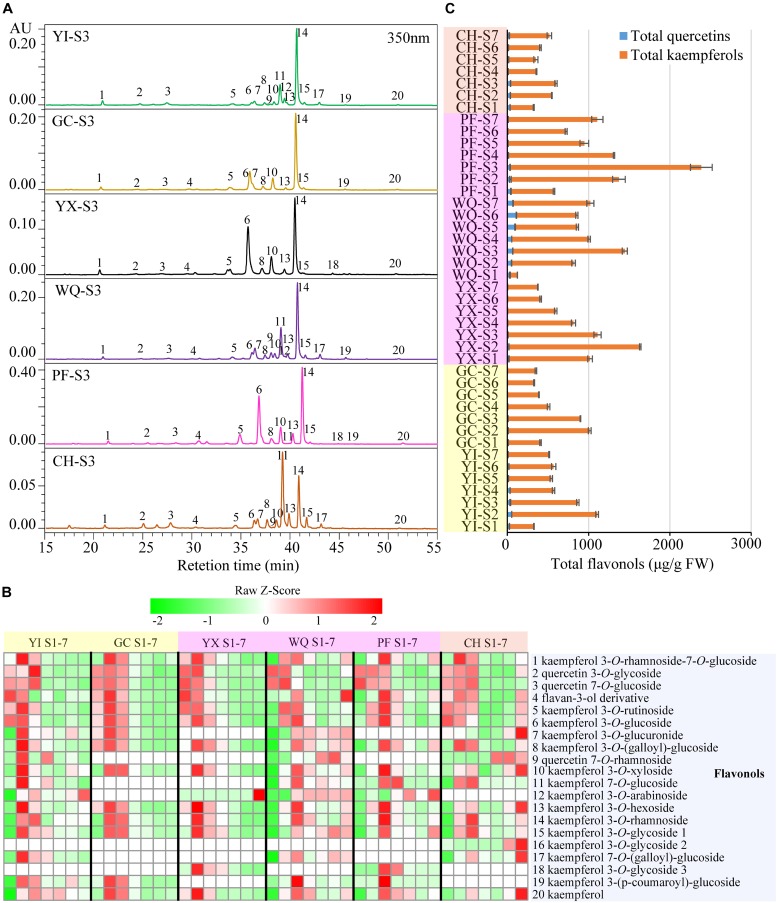
Contents of carotenoids extracted from rose petals of six cultivars at different developing stages. (A) HPLC chromatograms of carotenoids (detection at 450 nm): 1, (13Z) + (di-Z)-violaxanthin; 2, (all-E)-violaxanthin; 3, (13/13′Z)-antheraxanthin; 4, (all-E)-luteoxanthin; 5, (13/13′Z)-neoxanthin; 6, (9Z)-violaxanthin; 7, (all-E)-lutein; 8, (all-E)-zeaxanthin; 9, (9/9′Z)-lutein epoxide; 10, (all-E)-β-carotene. (B) A heat map of the individual carotenoid contents. Row represents Z-Score normalization of the concentation of identified carotenoids and column represents tested samples. Cells are colored based on concentrations in rose petals. Red represents relatively high concentration and green represents relatively low concentration of the identified carotenoids in petals of each rose cultivar at seven developing stages. Each value represents the average of three biological replicates. (C) The concentration of total carotenoids. Data represent the means of three biological replicates ± SD.